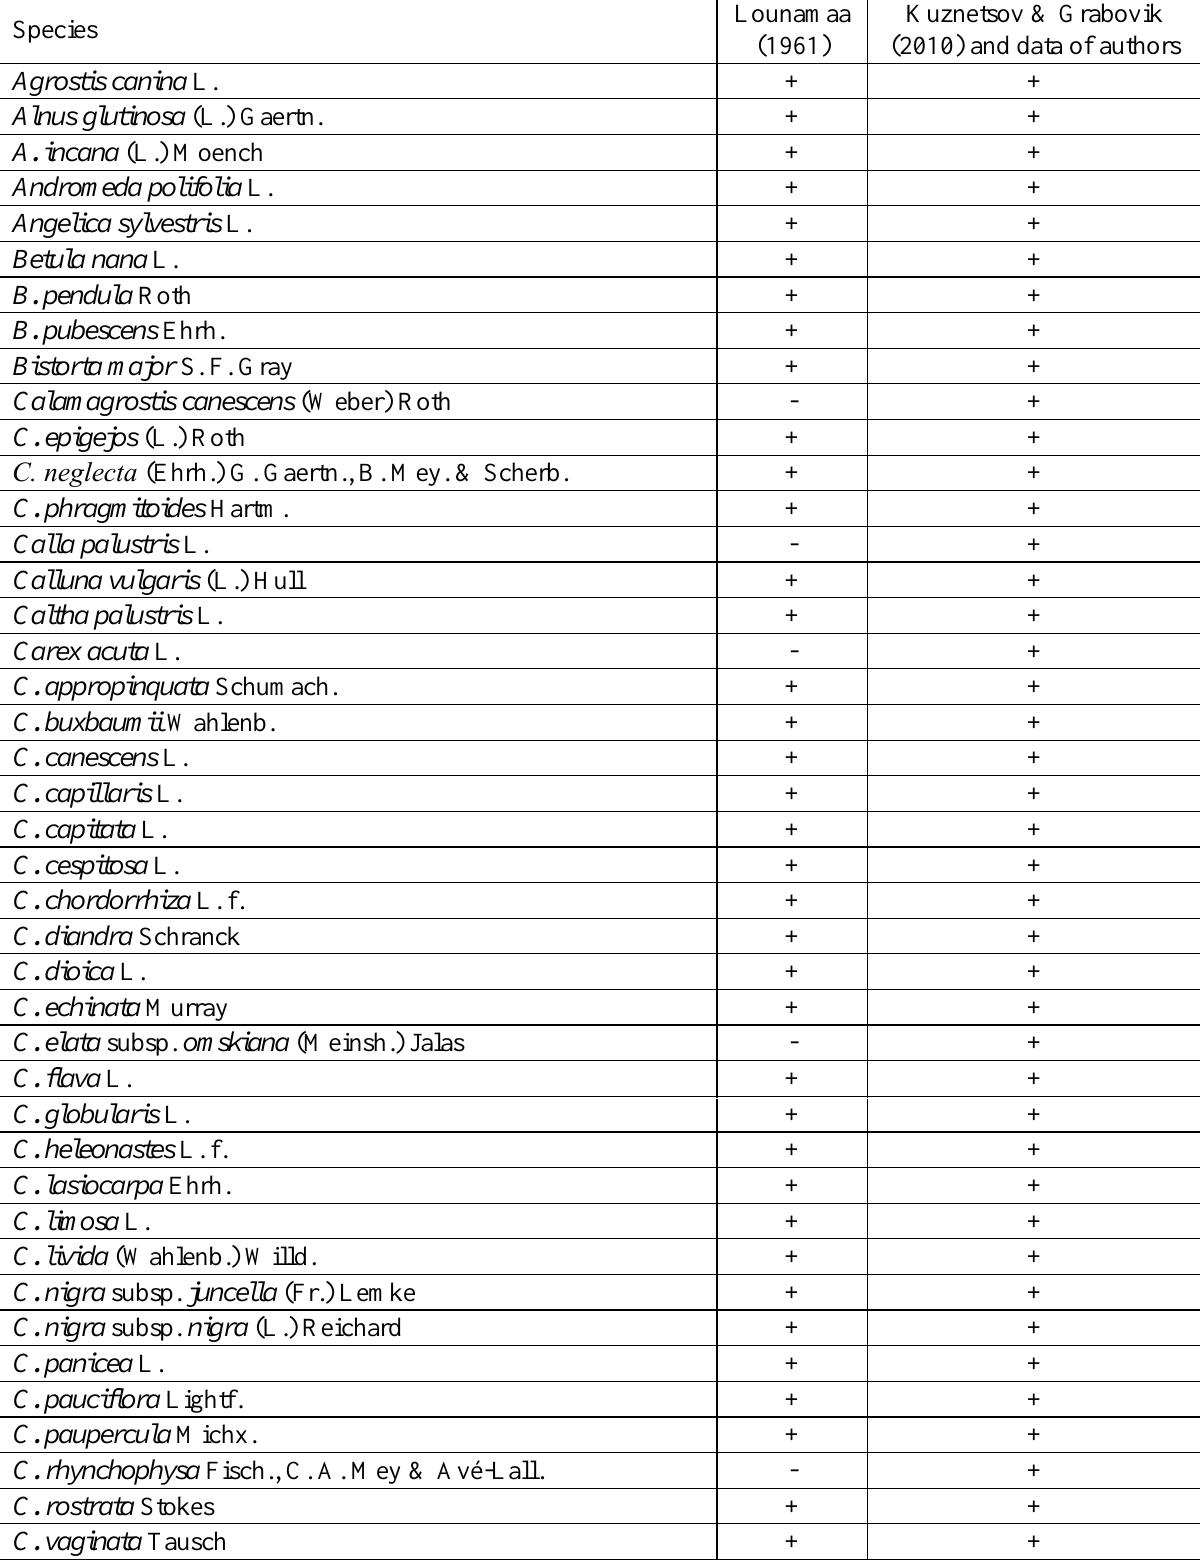
Lounamaa Kuznetsov & Grabovik (1961) (2010) and data of authors